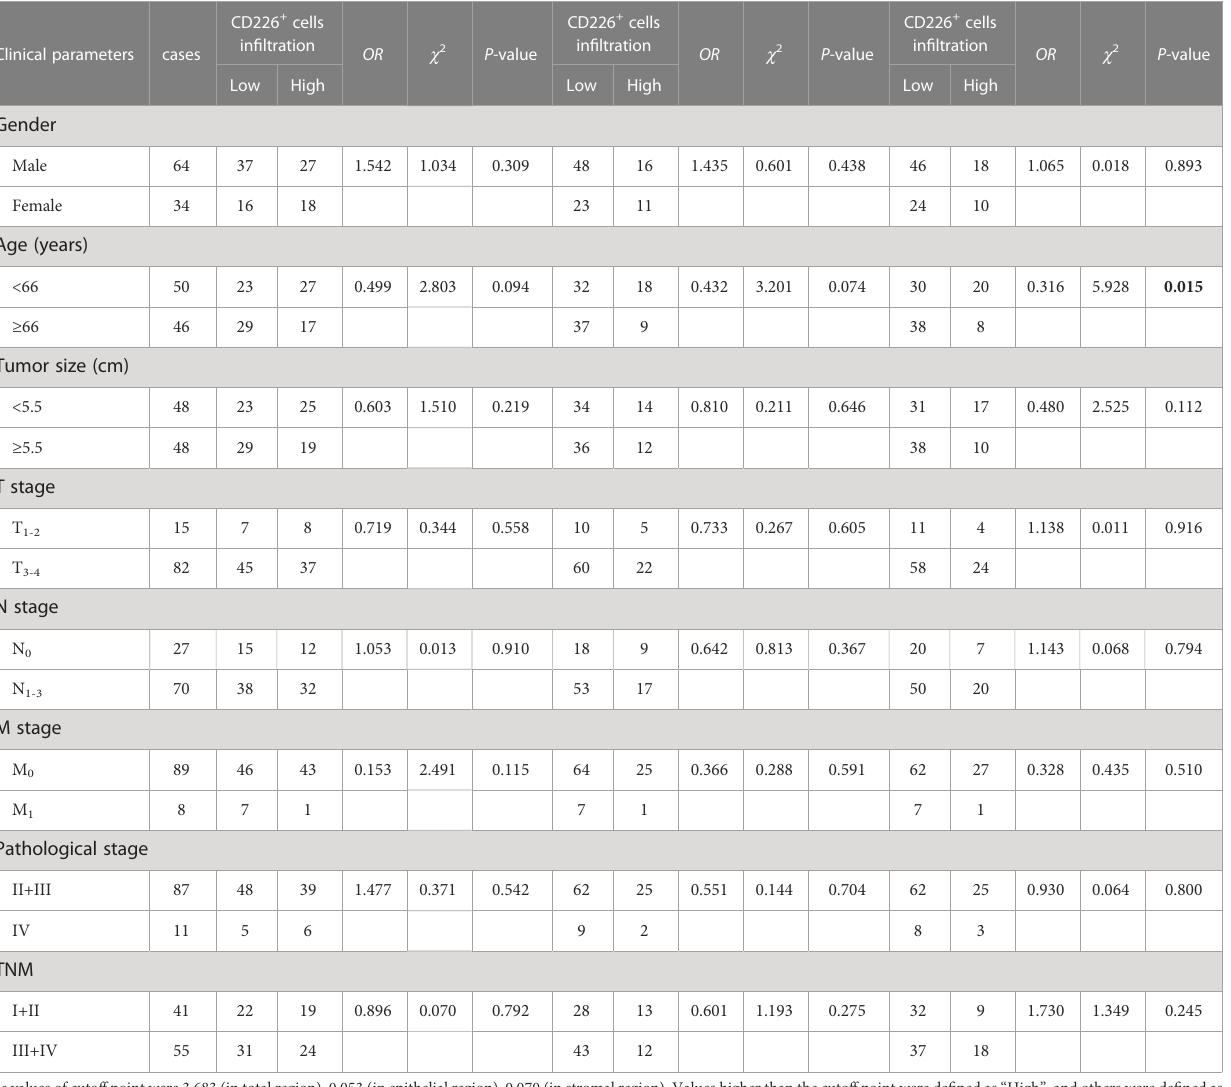
TABLE 2 The association between the percentages of CD226 + cells, CD226 + cells in the epithelial cell region, and CD226 + cells in the stromal cell region in tumor and clinical features of GC patients.